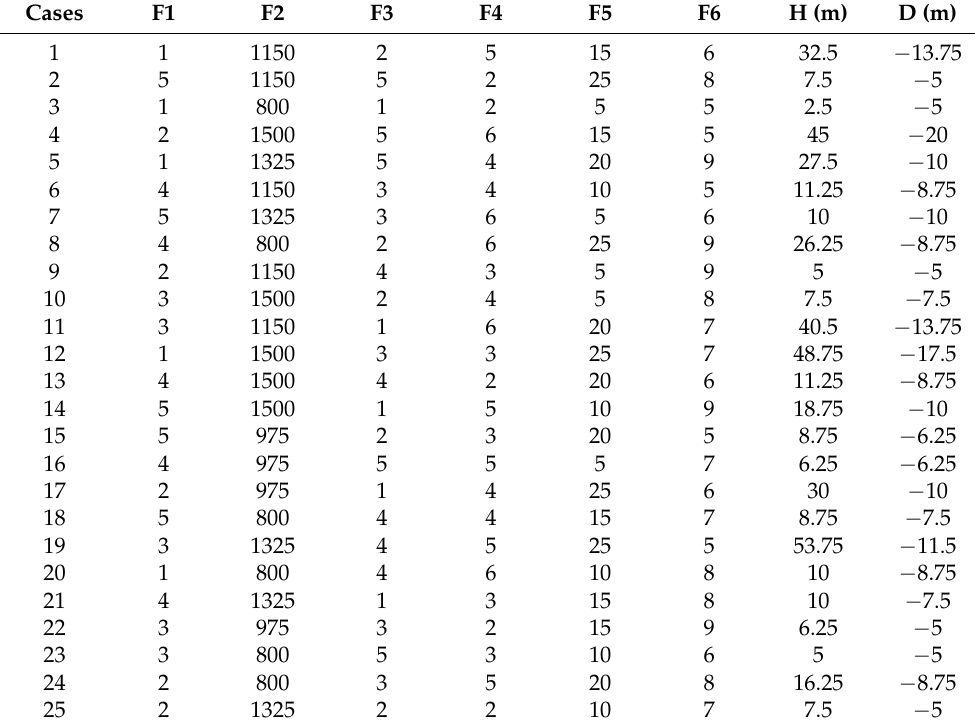
Table 6. Cases for orthogonal test and calculated